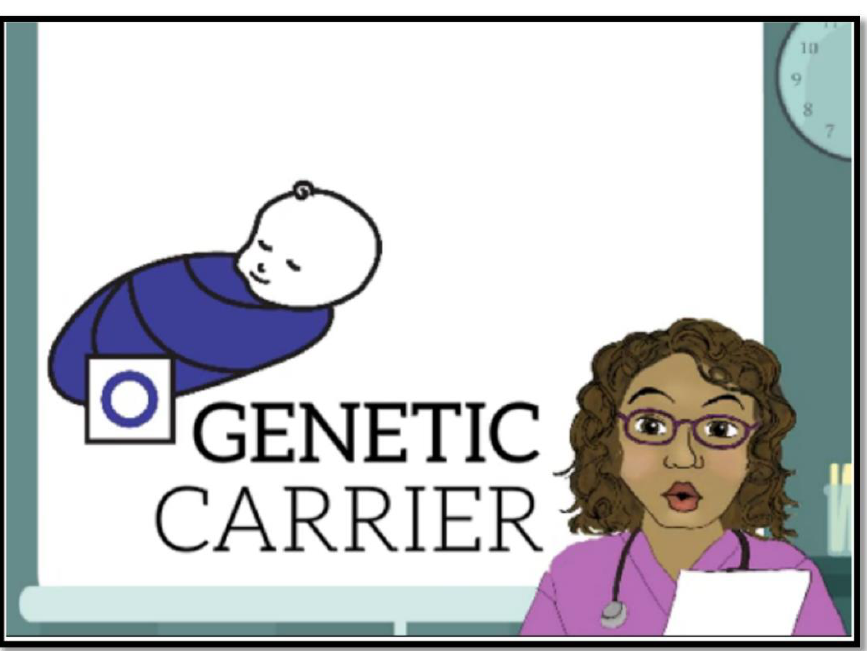
Figure 3. Still image from the third video detailing the meaning of carrier status. for “Disease X”. Full video available at https://www.youtube.com/watch?v=Y572EiX_hWY [last accessed on 25 July 2022].